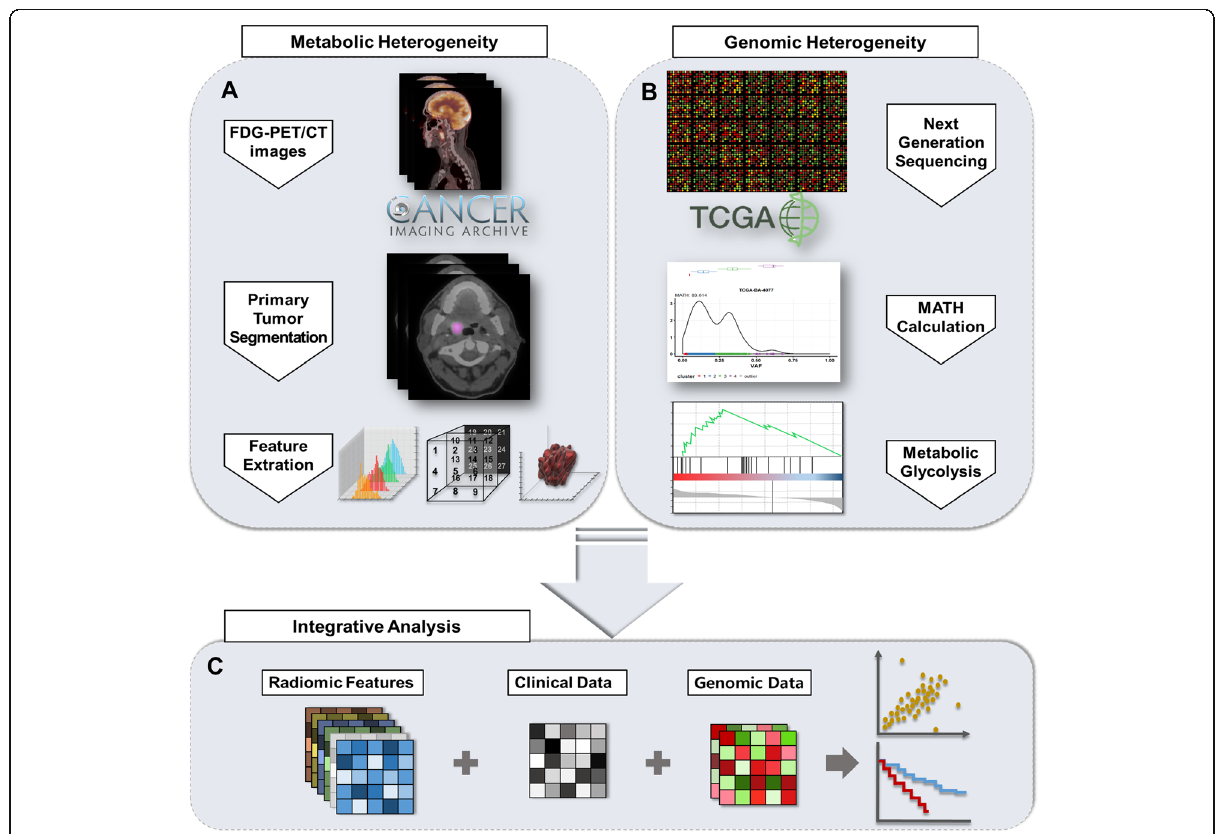
Fig. 1 Study scheme. A scheme for integrative study of radiogenomics. FDG PET data and genomic mutation data for TCGA-HNSC dataset were obtained from each database of TCIA and TCGA. a The primary tumor was manually assigned, and then ROIs were computed for feature extraction. b MATH calculation using MAF files were done in R. Also, metabolic glycolysis (GlycoS) value was obtained using gene set enrichment analysis. c Clinical data of TCGA-HNSC was gained from TCGA. Total six features were selected and used for radiogenomic analysis. We statistically analyzed radiomic, clinical and genomic data using correlation analysis, Kaplan-Meier analysis, log-rank